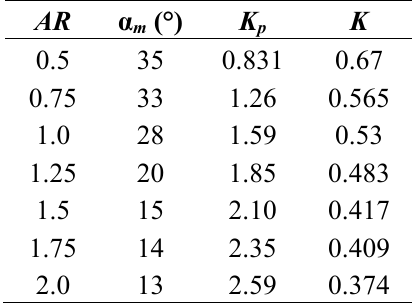
Table 1. Parameters for flat plate lift and drag from Torres and Mueller [7]. α m is taken